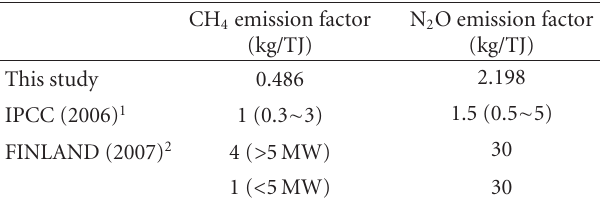
Table 8: Non-CO 2 emission factors of anthracite fluidized Bed power plant investigated in this